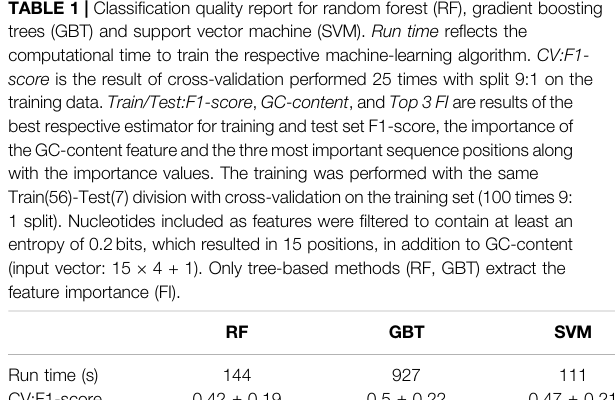
( Figure 4C ): below 200 samples represented by library g , the coef fi cient of variation rises, thus decreasing prediction con fi dence. Two scenarios are visible in Figure 4C , a and c display already a very low sequence diversity and for improving performance the sequence diversity should be increased. In contrast, libraries b , e , and f are diverse, and estimation performance would bene fi t by increasing the sample size even with related sequences. An interesting piece of information is the feature importance, for features that correlate with expression activity. Figure 4B indicates how the number of features affects the sum of the three top important features derived from the RF. The top-three feature importance sum decreases linearly with